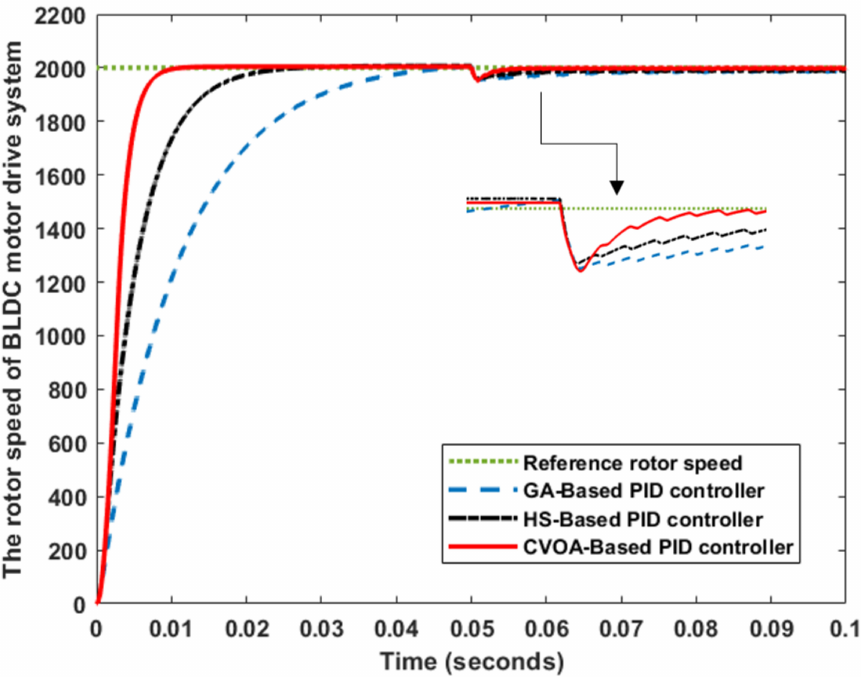
Figure 7. The speed of BLDC motor at speed regulation with sudden load